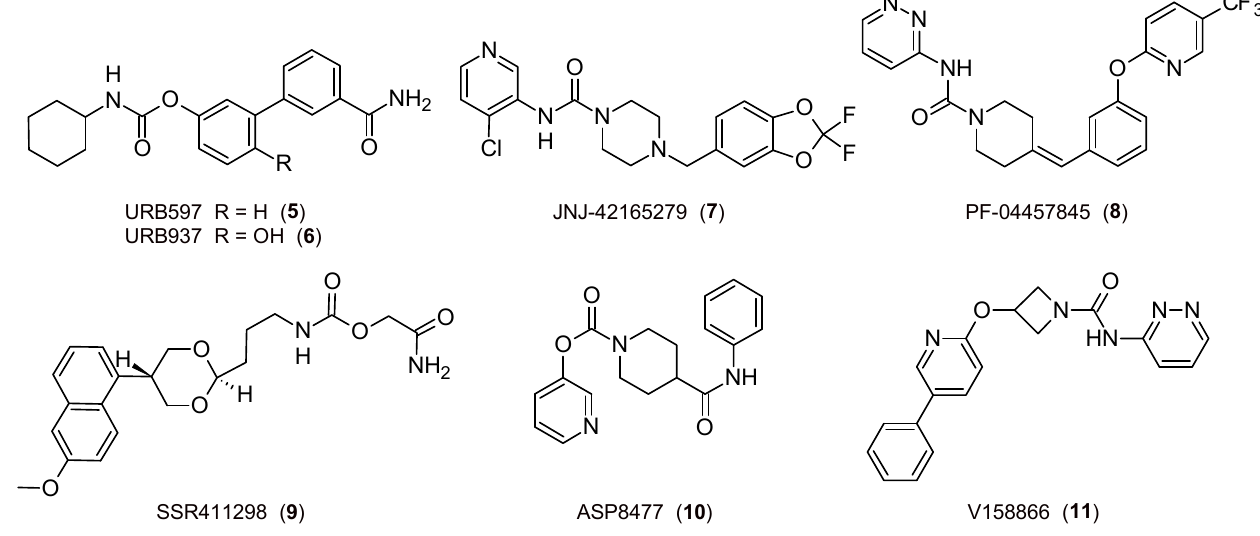
Figure 3. The 2D structures of selected FAAH inhibitors.